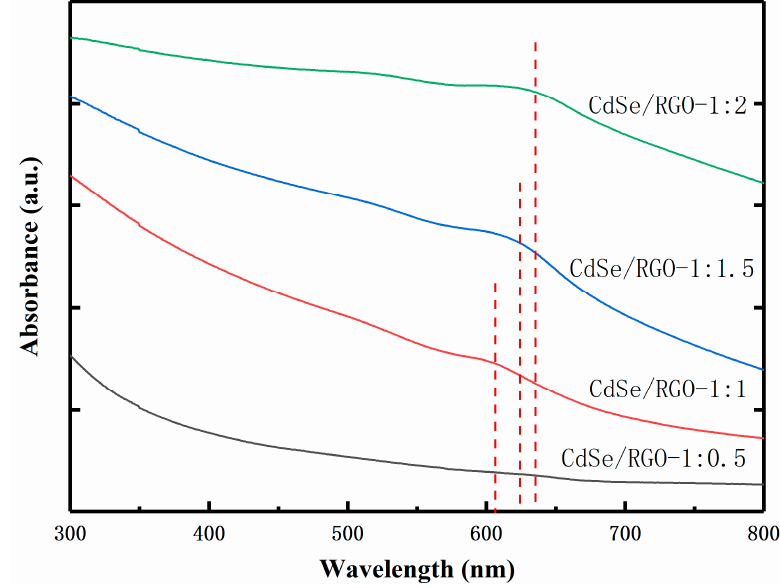
Figure 8. UV-Vis absorption spectra of CdSe/RGO-1:0.5, CdSe/RGO-1:1, CdSe/RGO-1:1.5 and CdSe/RGO-1:2.